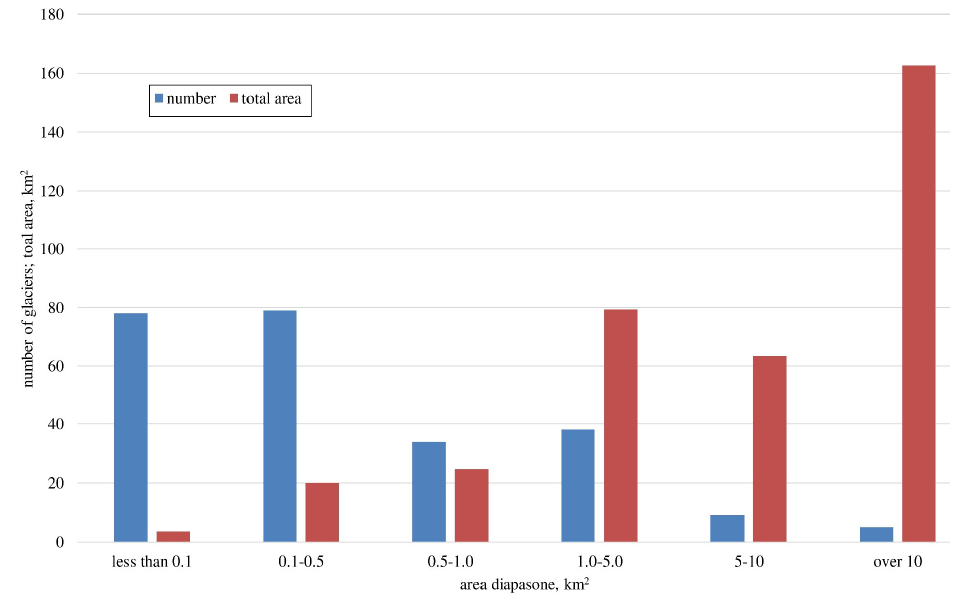
Figure 8. Distribution of the quantity and total area of glaciers at the peak of the LIA in different intervals of areas.